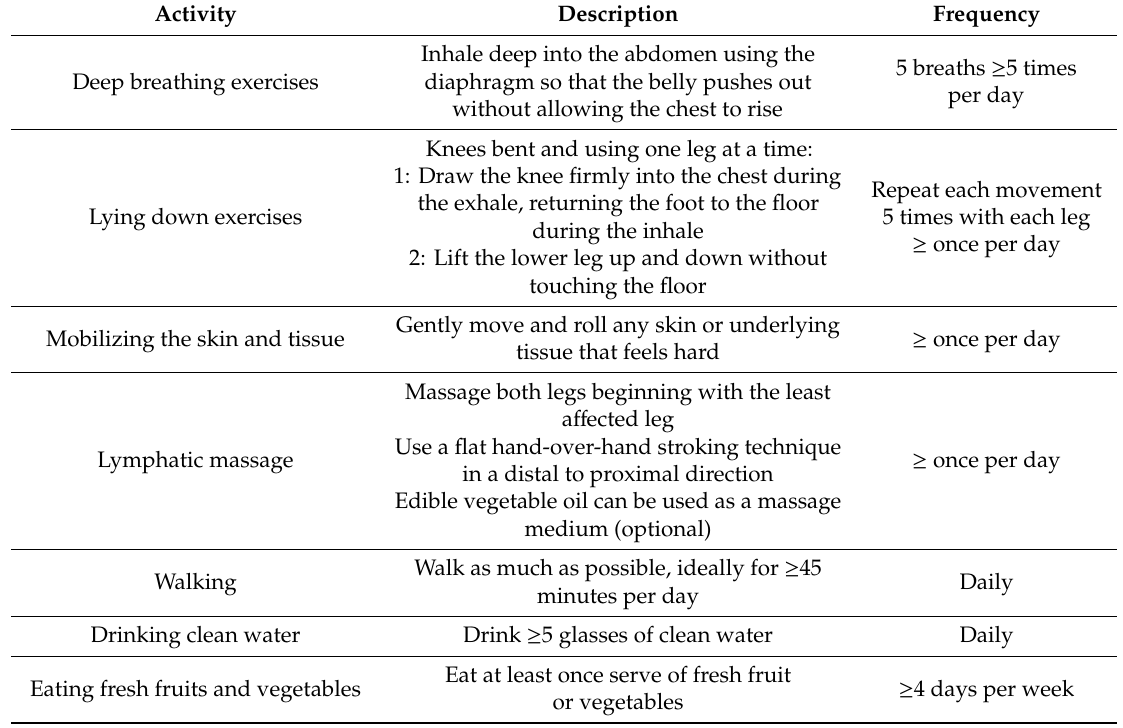
Table 2. Enhanced care activities (given in addition to all activities in Table